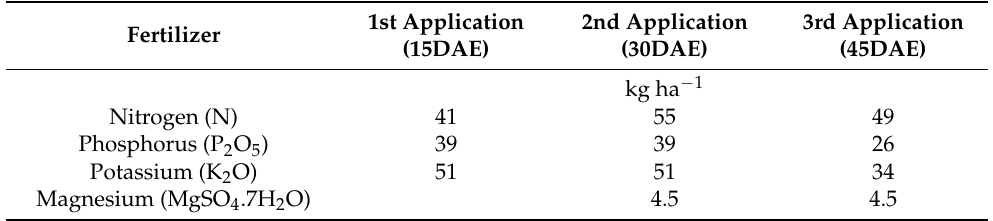
Table 1. Time and doses of fertilizer applications during the experiment.